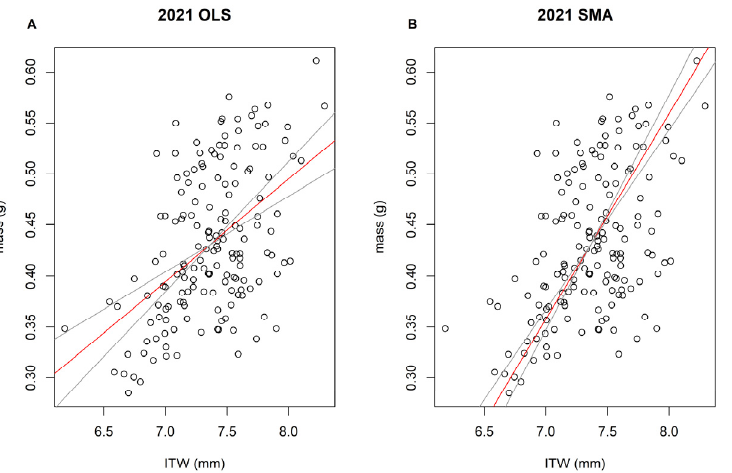
Figure A2. SMA regression was selected for 2021 after visual inspection and regression terms of mass and ITW relationships. Body condition predictions and regression outputs were compared for 2021 using OLS (left; intercept: − 0.309, slope: 0.101) and SMA (right; intercept: − 1.053, slope: 0.202) with red lines indicating the OLS ( A ) and SMA ( B ) regression lines and grey lines indicating the 95% confidence intervals of each slope.